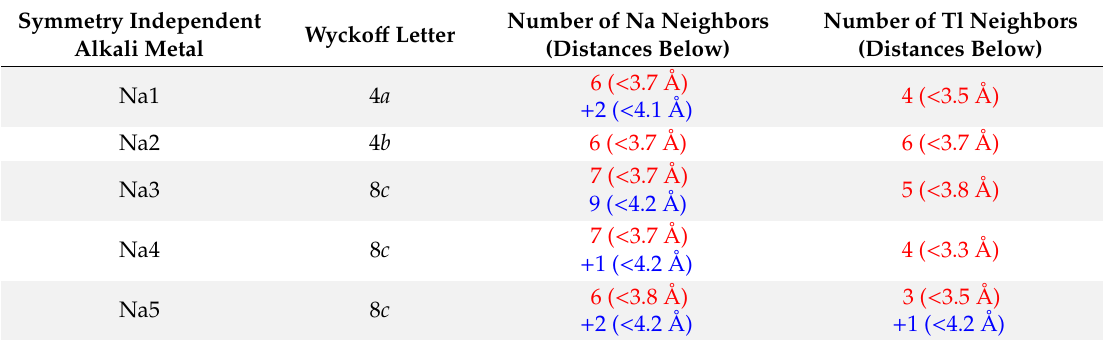
Table 15. Surrounding atoms of the symmetry inequivalent alkali metal positions in Na 2 Tl (space group C 222 1 ). The color-coding refers to the color of the contacts in Figure